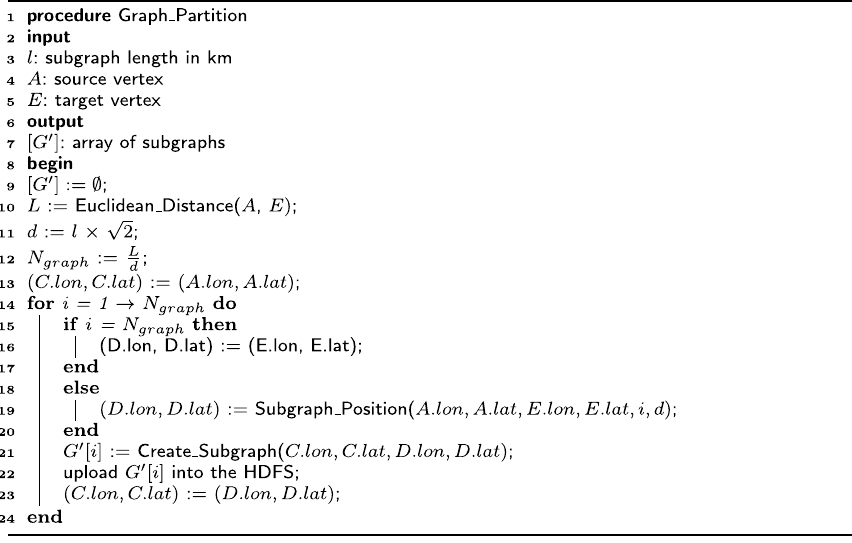
Algorithm 2 describes the Euclidean_Distance function for computing the distance between two points of the graph. It takes as input the starting and ending vertices (points A and E) and applies the Euclidean formula [2] to determine the distance L .